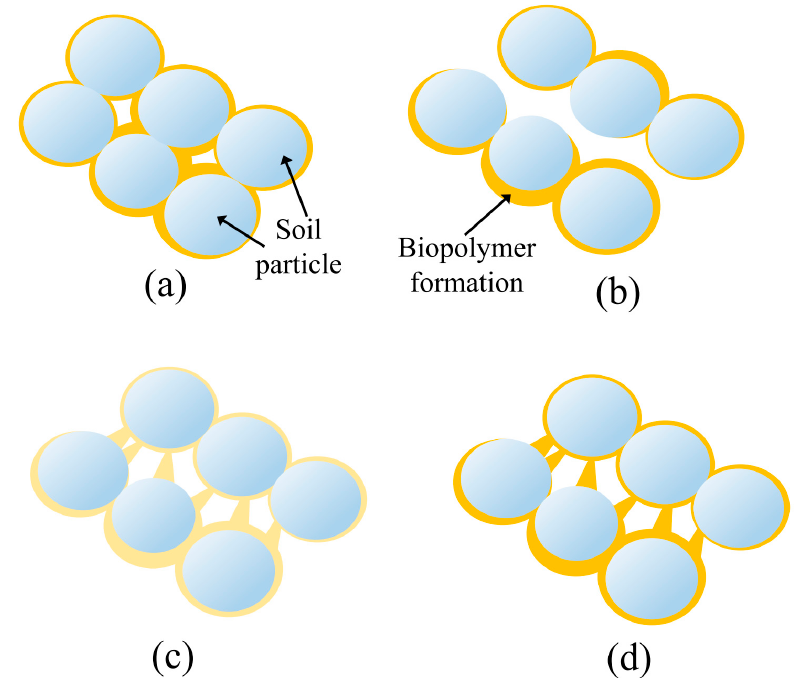
Figure 8. Healing cycle of biopolymer-treated sand: ( a ) sand particles bonded by XG-links, ( b ) breakage of the dry XG-links due to the applied mechanical loading, ( c ) XG- linkages loosen their structure in the contact with water which allows them to interact with the nearby sand particles; and ( d ) sand particles bonded again by new